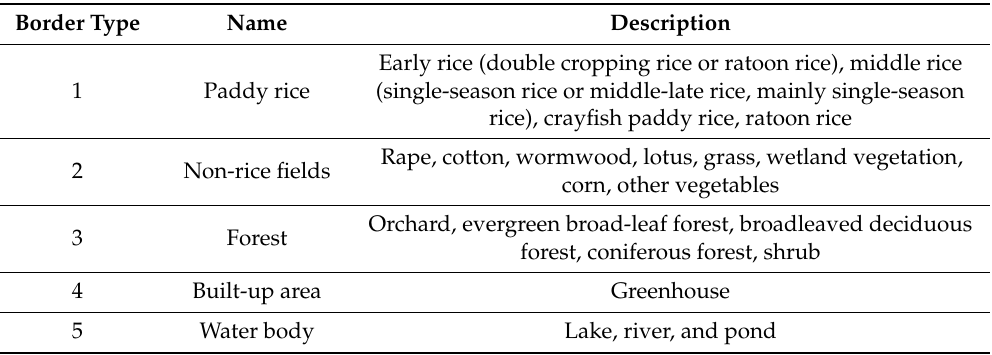
Table 2. Field survey data class and border